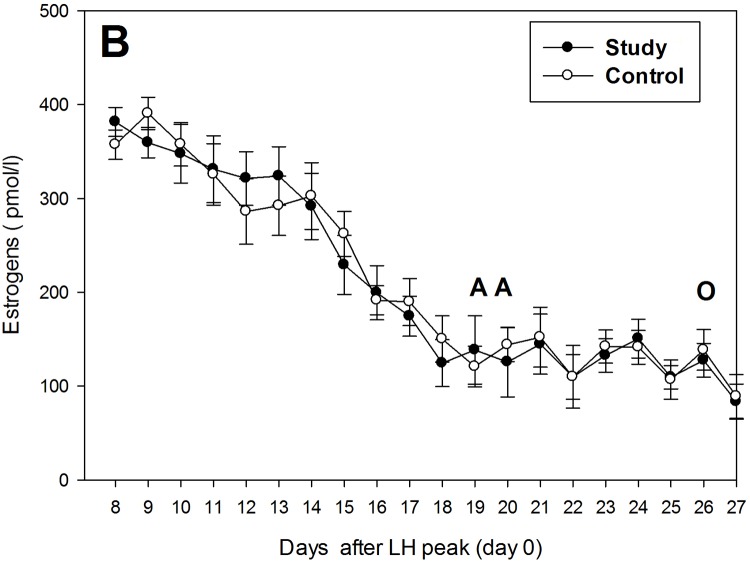
Serum estradiol concentrations in study (n = 9) and control (n = 5) bitches during the luteal phase, from days 8 to 27 after the estimated LH peak.The AA indicates days of treatment with aglepristone (10 mg/kg bw) or saline and O it is the day of castration. Results are expressed as means ± SD.